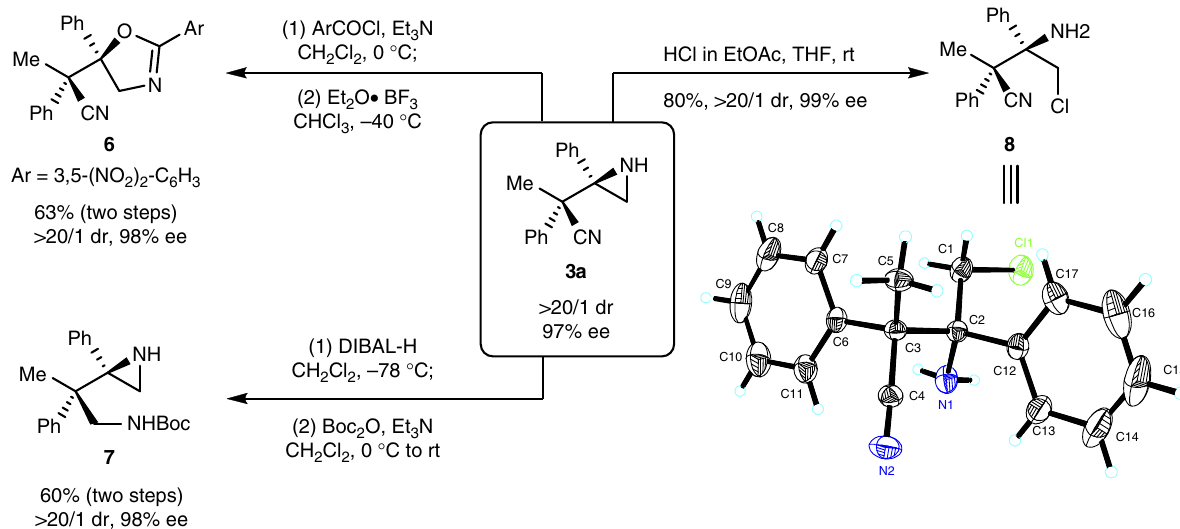
Fig. 4 Transformations of the product 3a . Boc, tert-butoxycarbonyl; DIBAL-H, diisobutylaluminium hydride